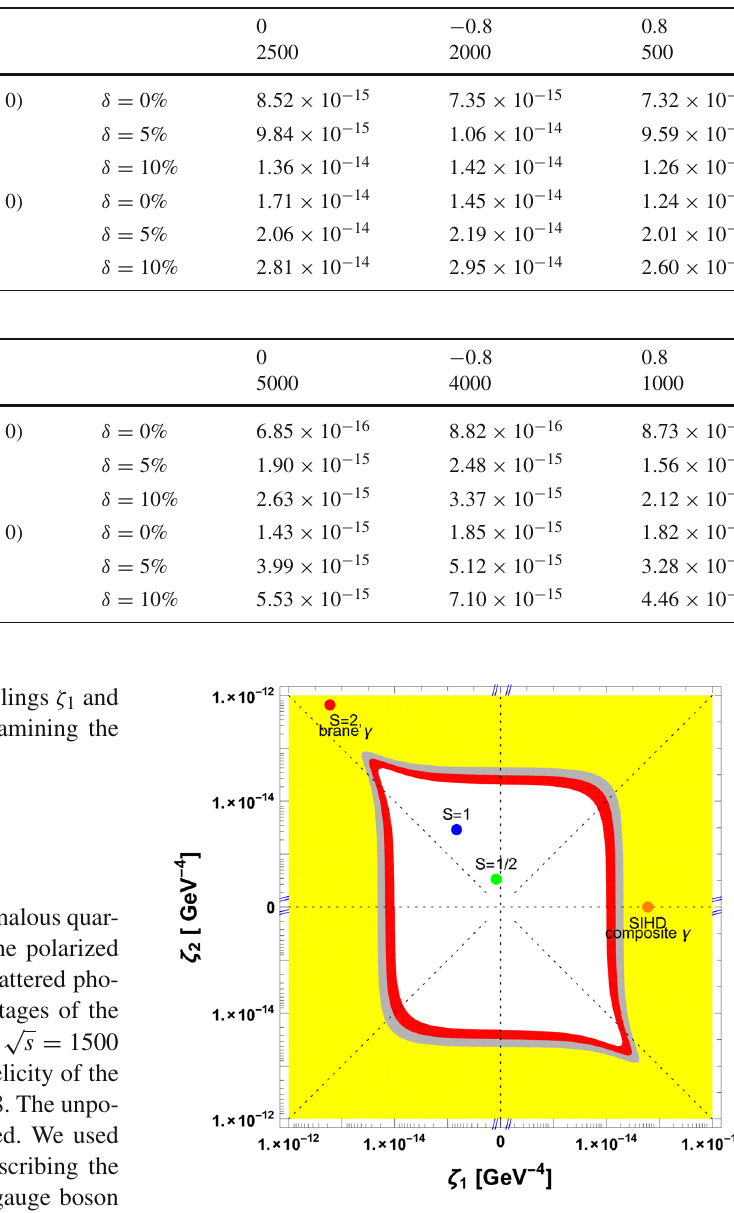
Fig. 8 The LHC sensitivity in the (ζ 1 ,ζ 2 ) plane. In particular, the red region can be probed at the 95% C.L. using proton tagging at the LHC. The white region is inaccessible. The figure is taken from Ref. [65]